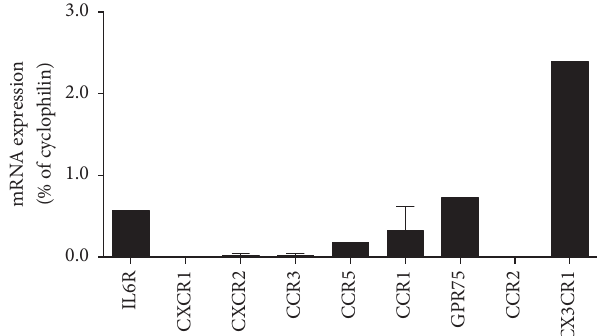
Figure 5: mRNA expression of myokine receptors in mouse islets. Quantification of myokine receptors mRNA in ∼ 400 pooled islets expressed as a percentage of cyclophilin mRNA levels in the same samples. Mean ± SEM. 𝑛 = 2